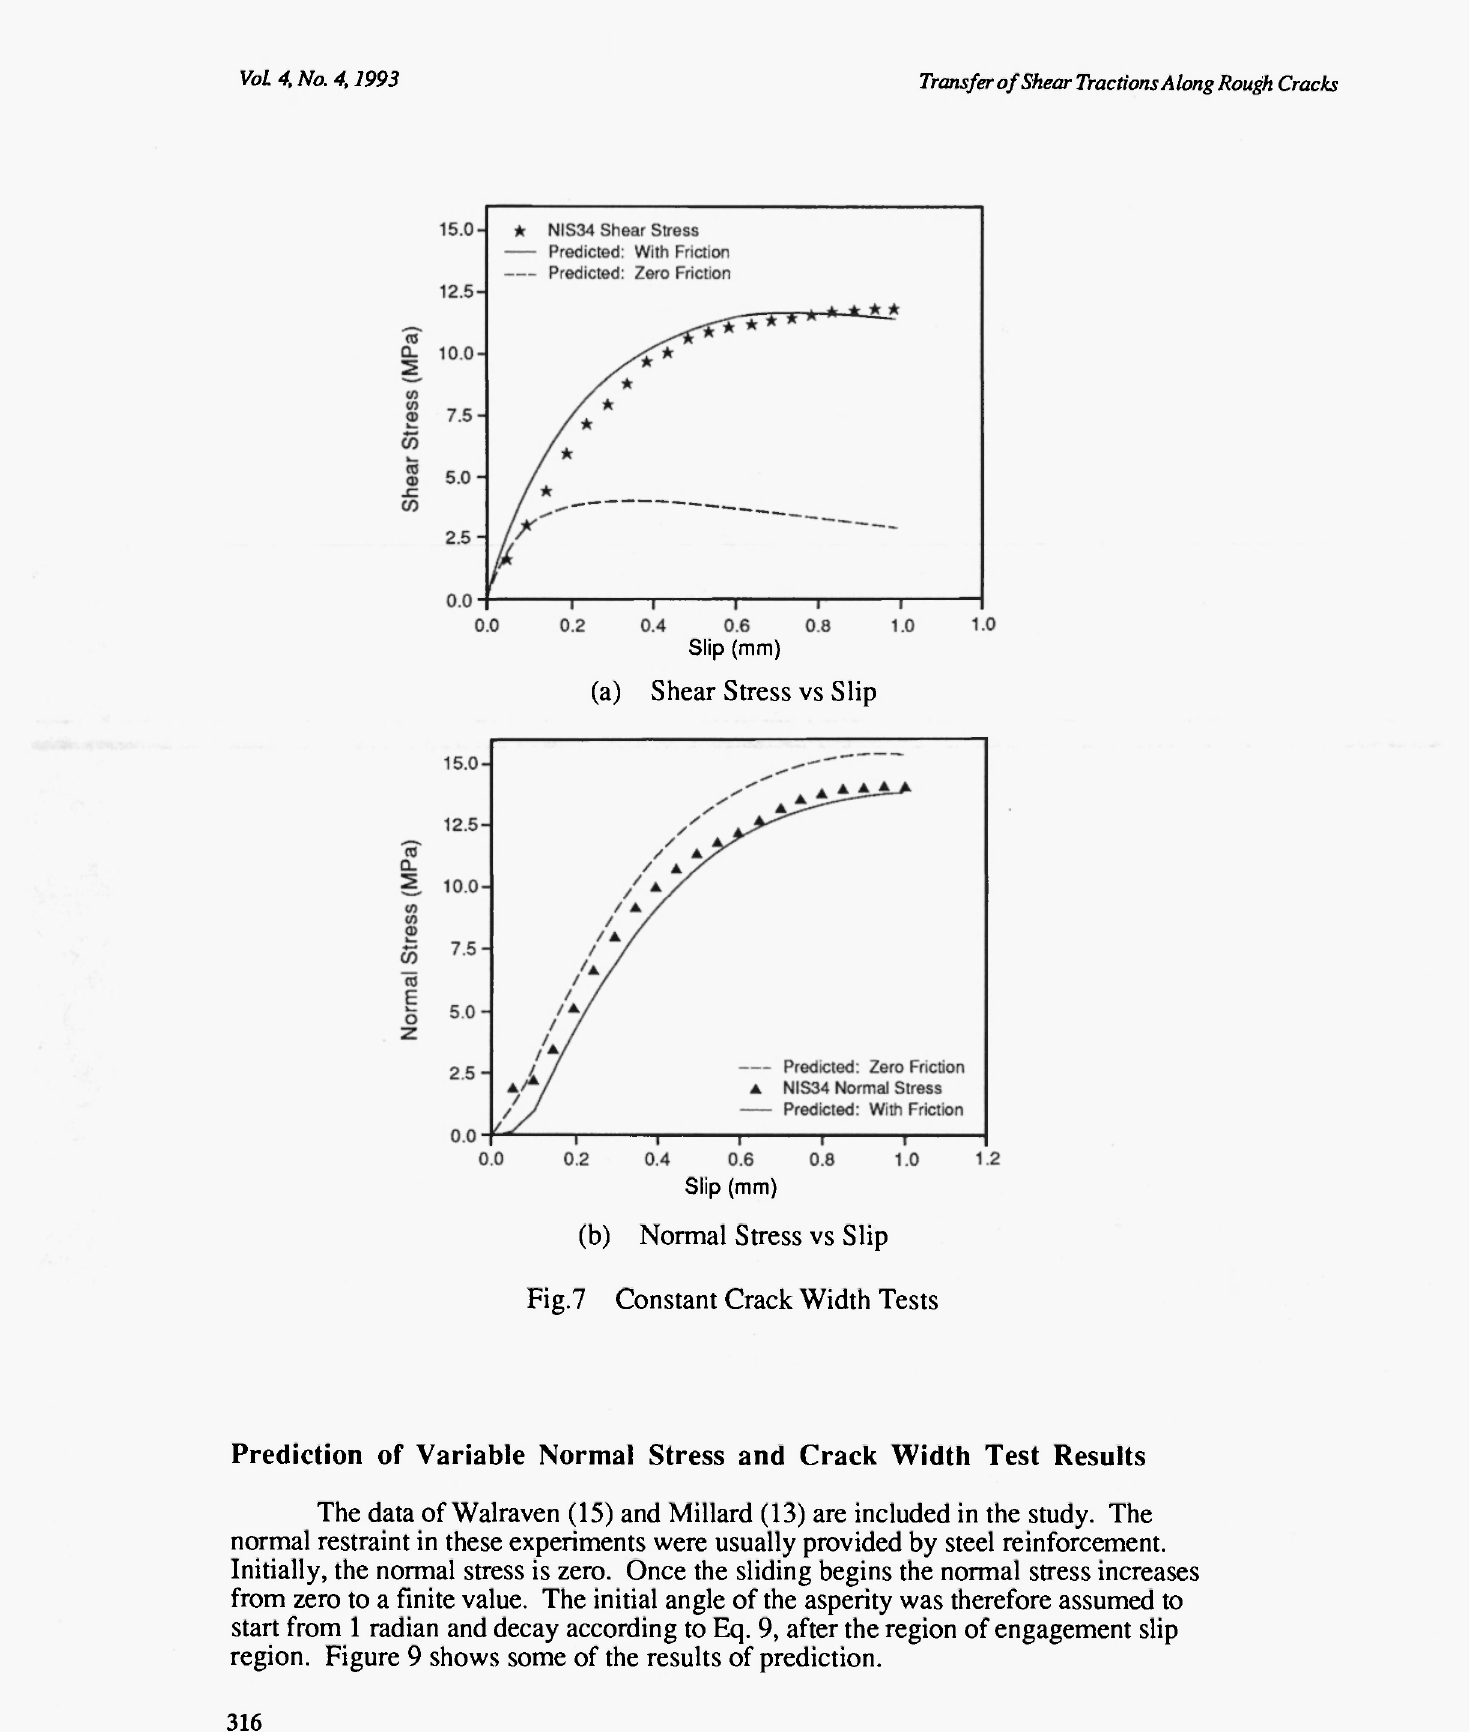
Prediction of Variable Normal Stress and Crack Width Test